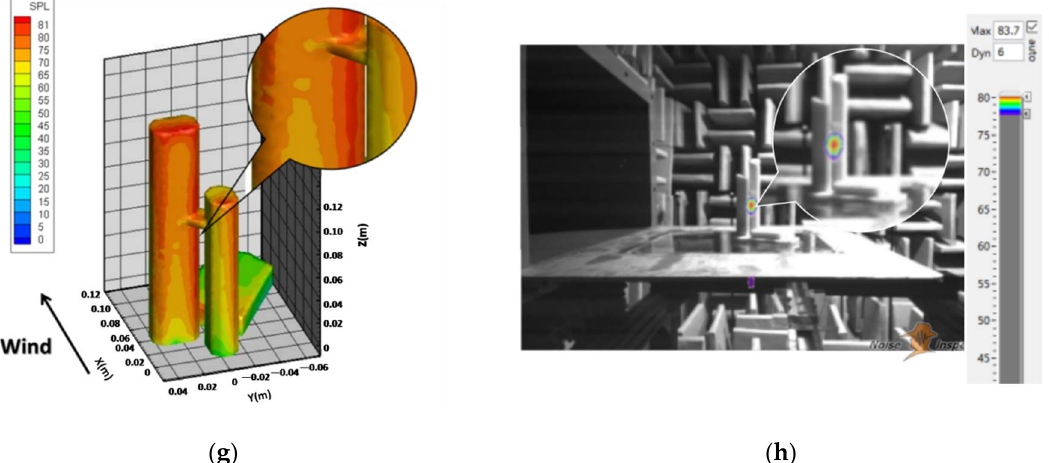
Figure 7. Comparison of experimental and simulated sound source localization at the wind angle of 0°. ( a ) 25 m/s numerical simulation; ( b ) 25 m/s wind tunnel experiment; ( c ) 30 m/s numerical simulation; ( d ) 30 m/s wind tunnel experiment; ( e ) 35 m/s numerical simulation; ( f ) 35 m/s wind tunnel experiment; ( g ) 40 m/s numerical simulation; ( h ) 40 m/s wind tunnel experiment.